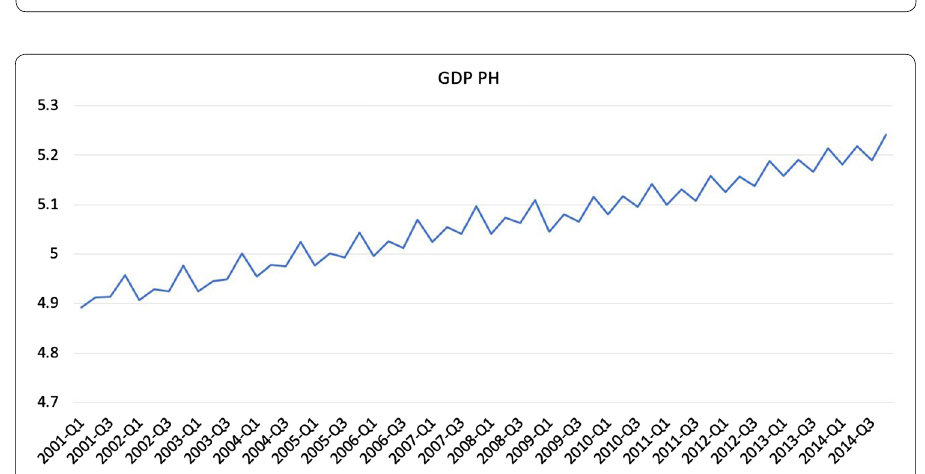
Fig. 4 Log (GDP of the